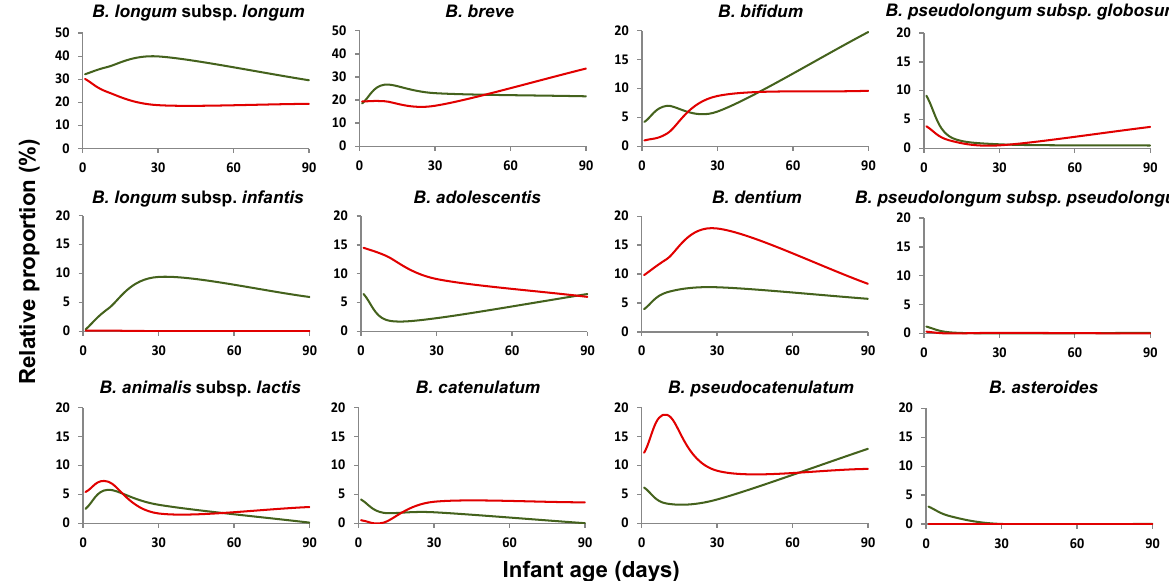
Figure 4. Average relative proportions, with regard to total bifidobacteria (100%), of the dominant Bifidobacterium species/subspecies during the first three months of life in exclusively breast-fed full-term vaginally delivered (green line) and formula/mixed-fed full-term vaginally delivered babies (red line).